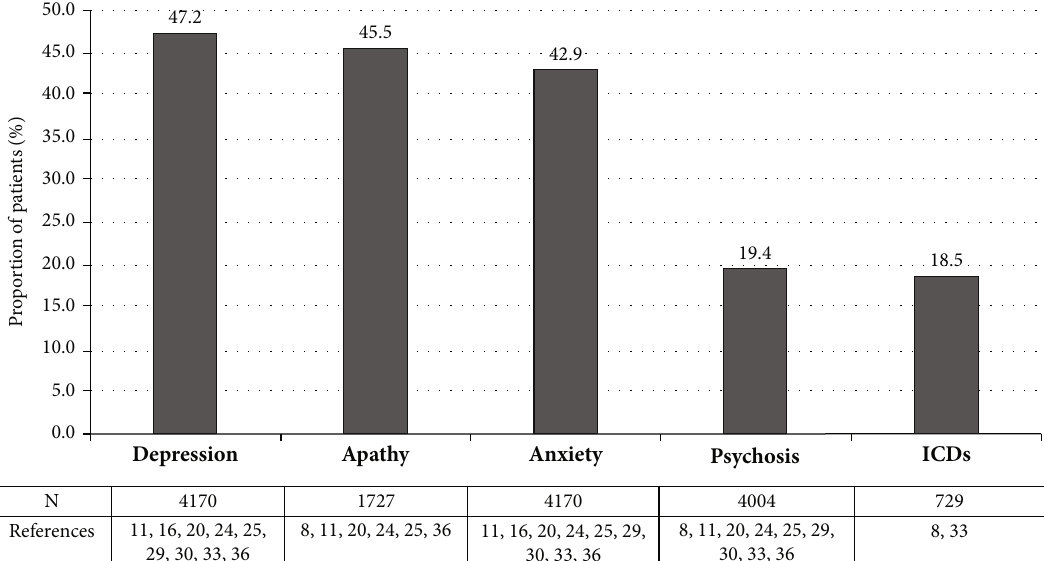
Figure 2: Most prevalent NPS in the PD sample. Only data from articles which reported NPS prevalence in percentage format was included in this fi gure [8, 11, 16, 20, 24, 25, 29, 30, 33, 36]. It should be noticed that the data reported may not have a unique origin as di ff erent instruments of assessment were used. Data reported in scoring format was not